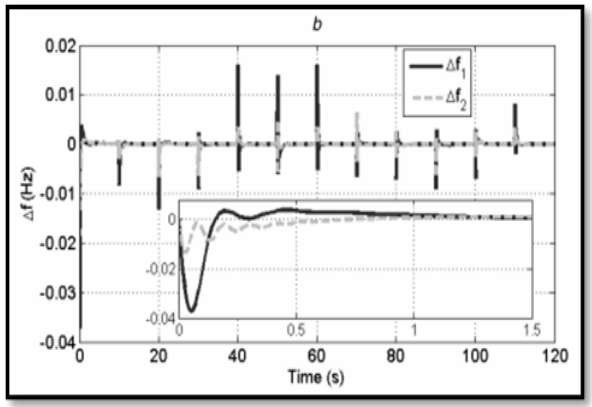
Figure 5. Tie-line power loading